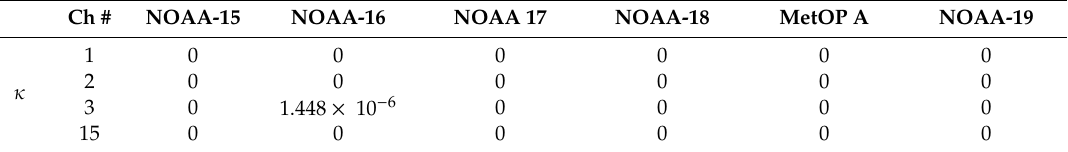
detailed in the next section. Table 5. Calibration coefficients for AMSU-A Channels 1–3 and 15 a .